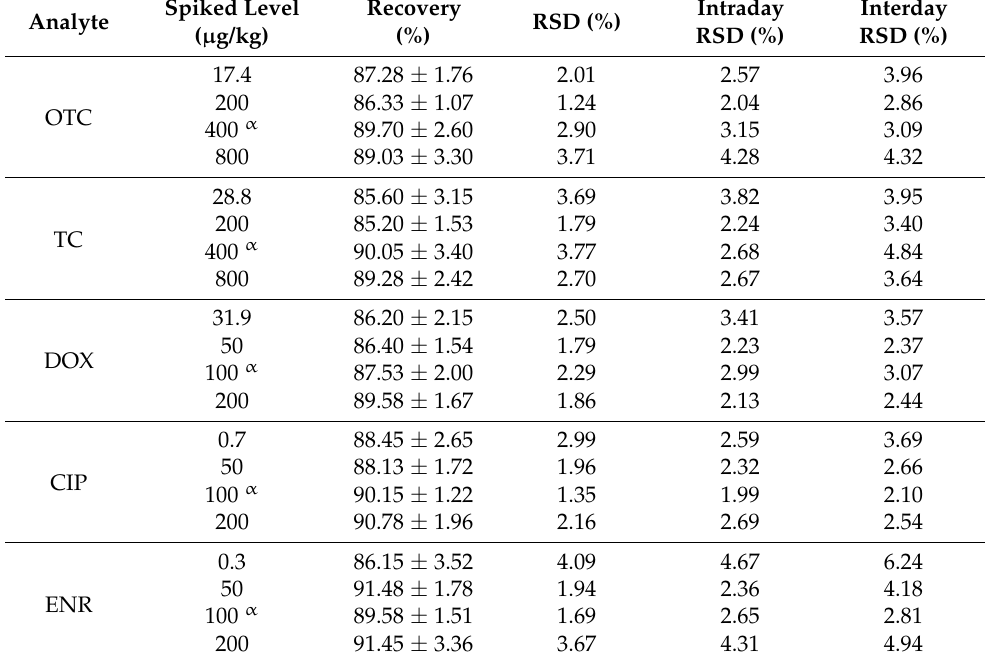
Table 3. Recovery and precision for analyses of blank chicken albumen spiked with OTC, TC, DOX, CIP and ENR (n =